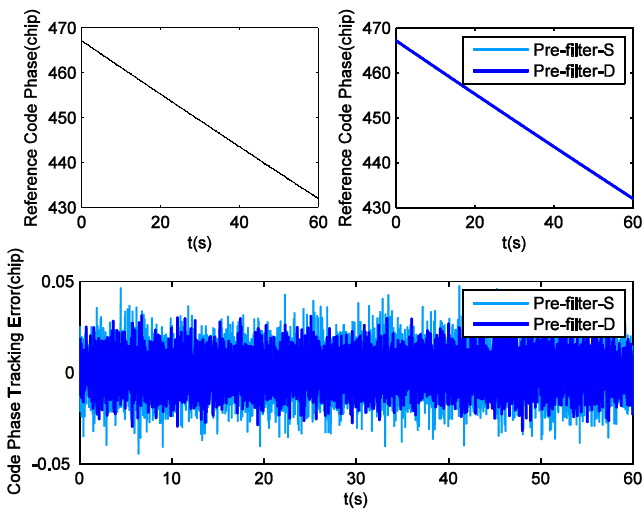
Figure 5. Code phase tracking error for PRN25 in field test.